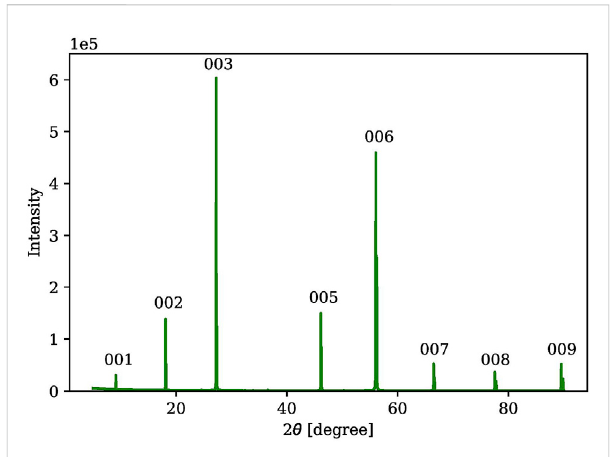
FIGURE 4 Single crystal XRD pattern of gel-grown of Cs 3 Bi 2 Br 9 single